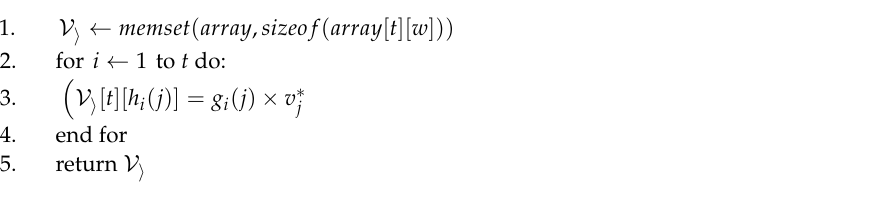
Algorithm 3: MDLDP ‐ CS algorithm